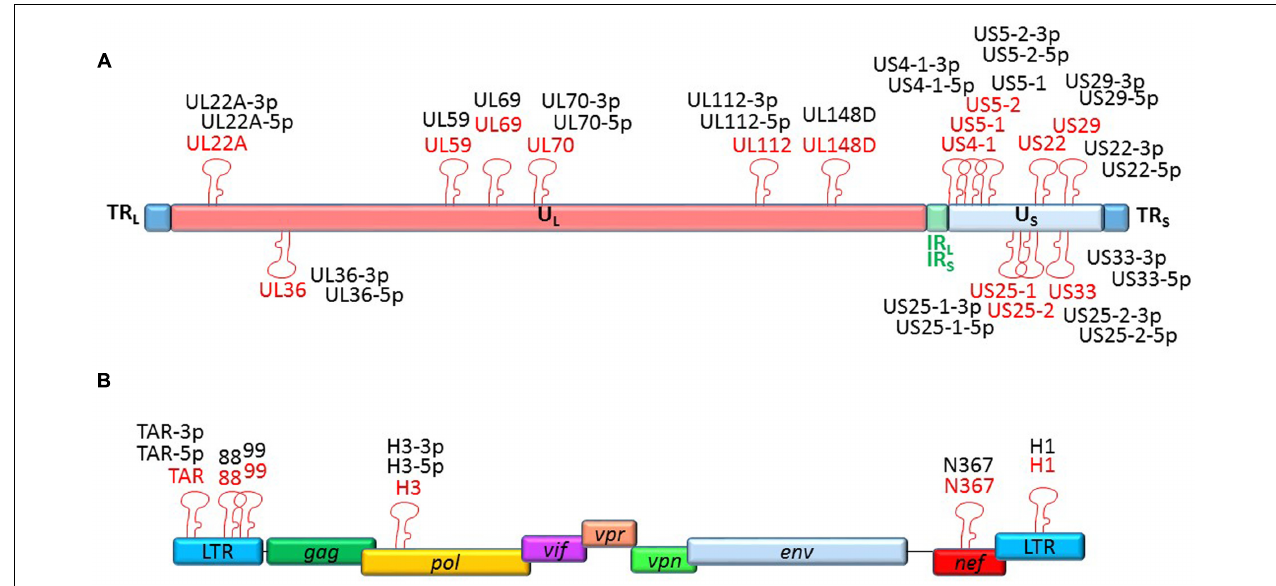
FIGURE 2 | Genomic organization of the miRNAs encoded by HCMV and HIV-1. Location of precursors (red) and mature (black) miRNAs is shown by hairpin loop structures along the linear representation of the HCMV (A) and HIV-1 (B) genomes. miRNAs shown above the line representing viral double-strand DNA are transcribed in sense direction (from right to left), while those shown below are transcribed in the opposite direction.